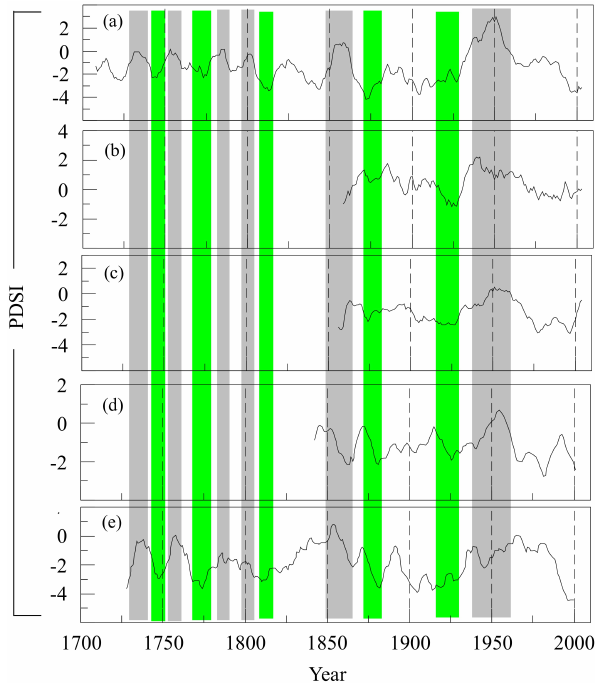
Fig. 7. Comparisons of the March–August mean PDSI reconstruc- tion (a) with the April–July PDSI reconstruction of the Guancen Mountain (Sun et al., 2012) (b) , the May–June mean PDSI of the Taihang Mountain (Cai and Liu, 2013) (c) , the May–July PDSI re- construction in the Ortindag Sand Land, east Inner Mongolia (Liang et al., 2007) (d) , and (e) the May–July mean PDSI reconstruction for the Kongtong Mountain, Gansu Province (Song and Liu, 2011). The lines are the 11yr moving average. Green and grey bars show the dry and wet periods, respectively. Locations of these compared PDSI series were shown in Fig.